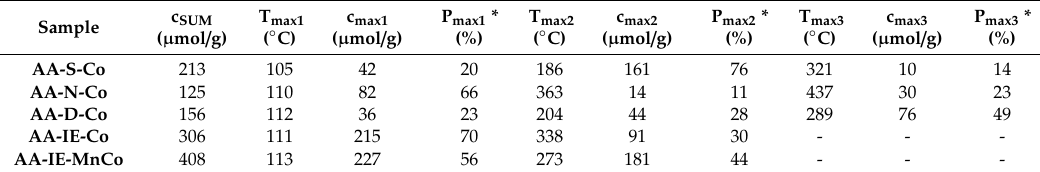
Table 3. Basicity of cobalt catalysts determined by CO 2 -TPD.